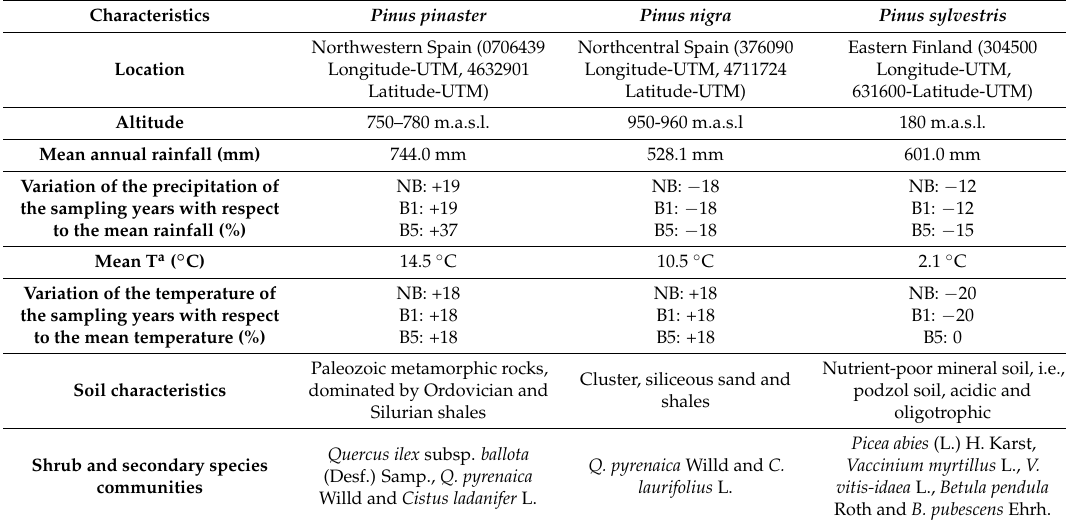
Table 1. Location, climate, soil, and shrub vegetation characteristics of the studied sites.